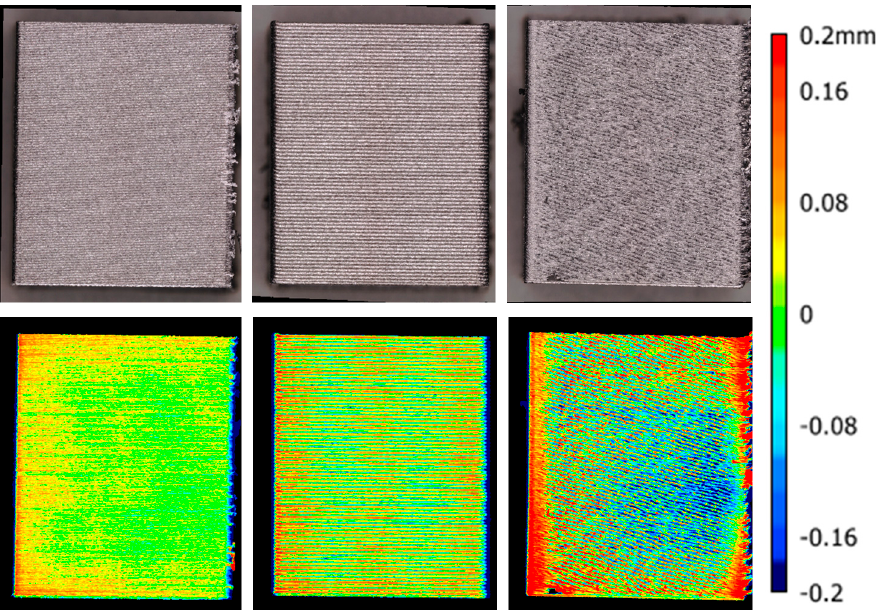
Figure 5. Examples of different surface qualities: Left: N9 with the lowest measured surface rough- ness; Center: N14 with large layer lines; Right: N23 with artefacts due to jagged extrusion lines.